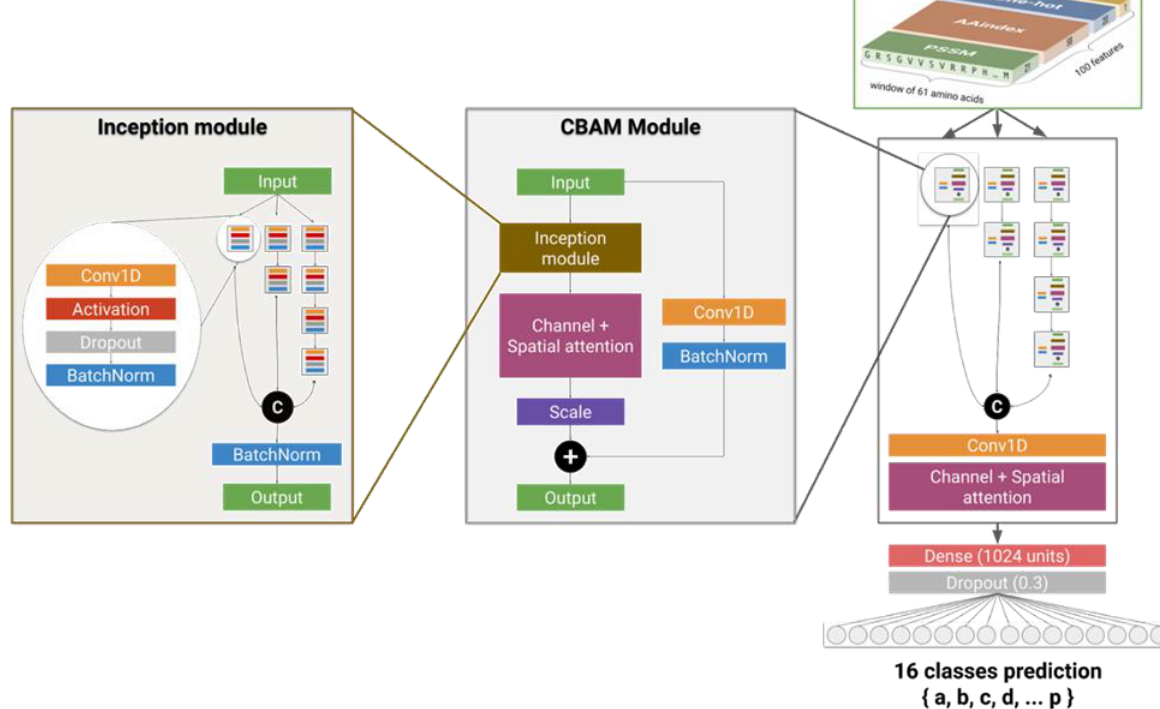
Figure 7. Deep neural network developed for the prediction of Protein Blocks. In the inception module, outputs of branches are concatenated (“C”). In the CBAM module, the residual connection is added to the main branch (“+”). The first 1D convolutional layer of the inception modules use a kernel size of 1 and the layers of higher depth levels use a kernel size of 3. The last 1D convolutional layer of the whole network uses a kernel of 11. All convolutional layers of the model have 128 filters.